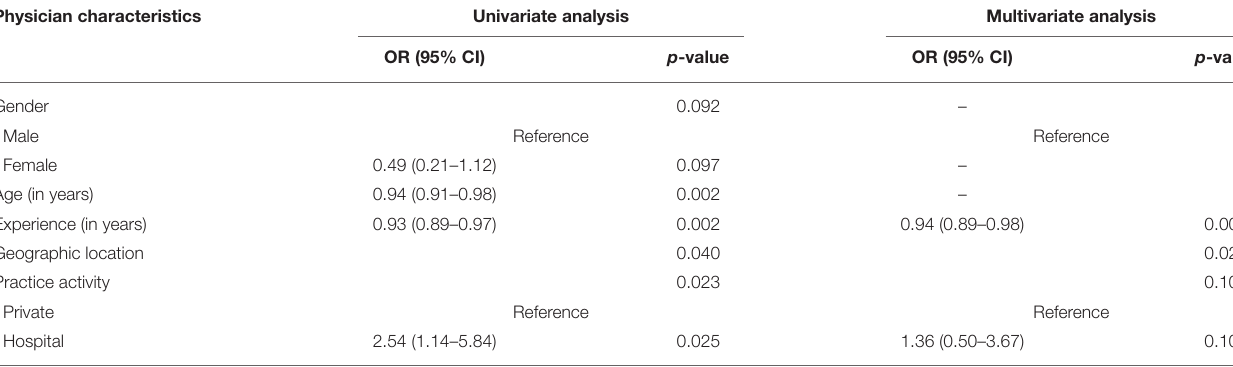
TABLE 2 | Effect of age, gender, activity type, geographic location, and experience on the use of a